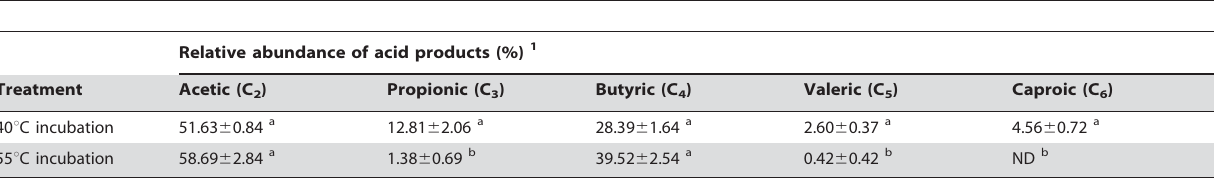
Table 1. Distribution and relative abundance (%) of fermentation products following 16 day’s incubation under contrasting fermentation temperatures.